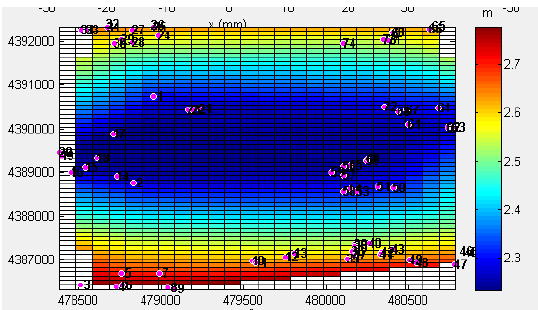
Figure 2.a Position uncertainty of X component of each point